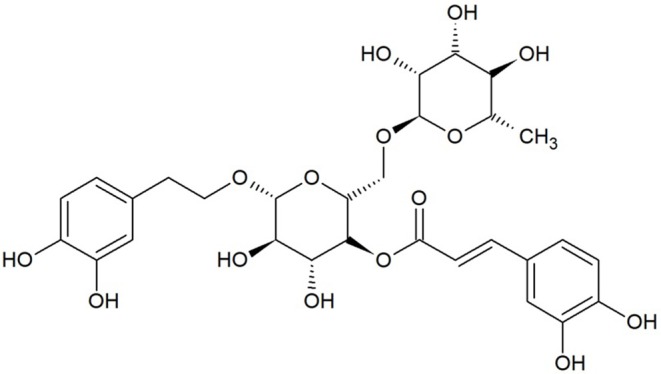
Forsythoside A (C29H36O15).